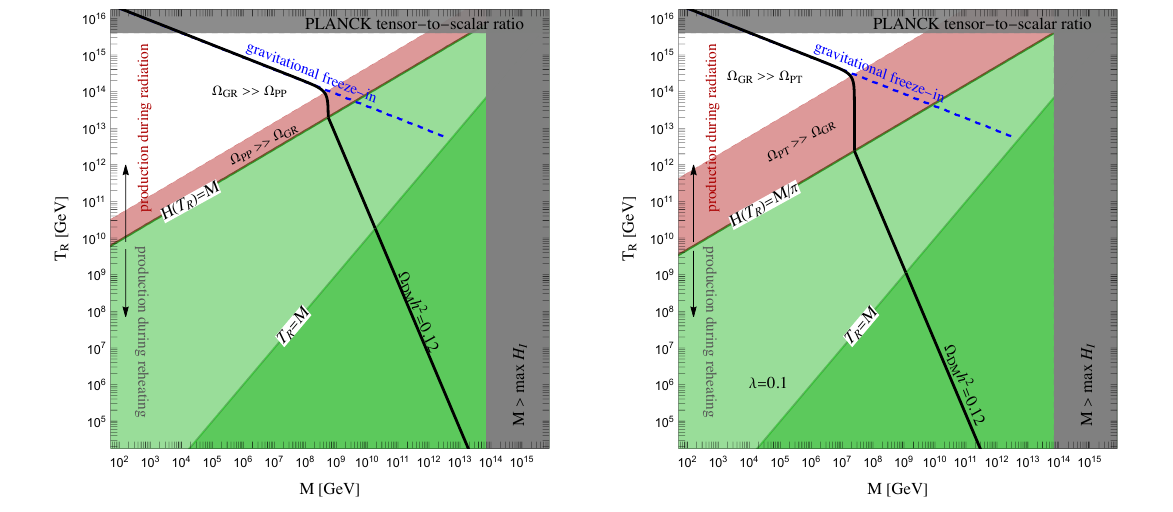
Figure 2 . Parameter space of the conformally coupled scalar. The DM abundance is reproduced along the black solid line. The darker green region corresponds to T where the gravitational R ≤ M freeze-in (blue line) becomes inefficient (see eq. (2.1)). The lighter green region corresponds to H R ≤ M where the particle production (left panel) or phase transition (right panel) happen during reheating. The red region is highlighted to show where the contribution from particle production (left panel) or phase transition (right panel) generated in radiation domination dominate over the gravitational freeze-in. Gray regions are